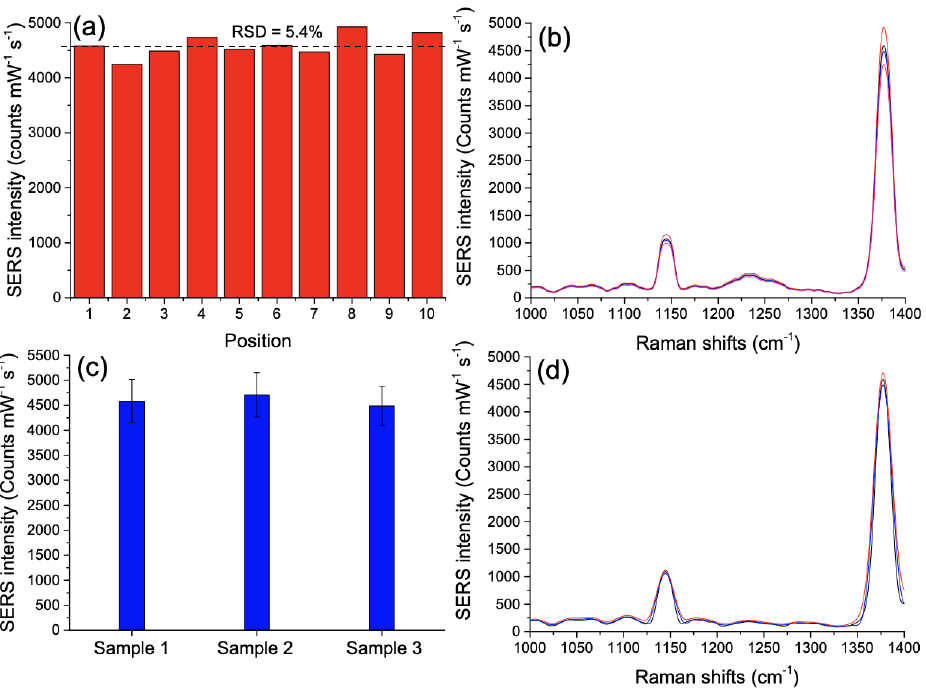
Figure 3. ( a ) SERS intensity recorded for the Raman peak at 1378 cm − 1 at ten positions taken randomly on the substrate (the black dashed line represents the average value of the SERS intensity with a RSD value of 5.4%). ( b ) SERS spectra for four positions of ( a ): in red at the position 8, in black at the position 6, in blue at the position 3 and in pink at the position 2. ( c ) SERS intensity distribution of the 1378 cm − 1 peak for three distinct samples with an average RSD < 9%. ( d ) SERS spectra associated to three samples: in red for the sample 2, in black for the sample 1 and in blue for the sample